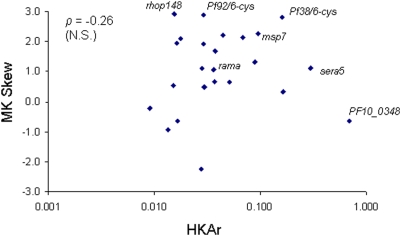
Scatterplot of McDonald-Kreitman (MK) skew (log2 transformation of the neutrality index with 0 representing no skew) and Hudson-Kreitman-Aguade ratio (HKAr) of polymorphism (in P. falciparum) and divergence (between P. falciparum and P. reichenowi) for each of the genes studied in Table 1.Two of the 26 genes had no polymorphism and are not plotted. There was no significant correlation between the two indices (Spearman's ρ = −0.26). Six genes at the outer fringe of the distributions, and one in the middle, are labelled and were selected for population based analysis.